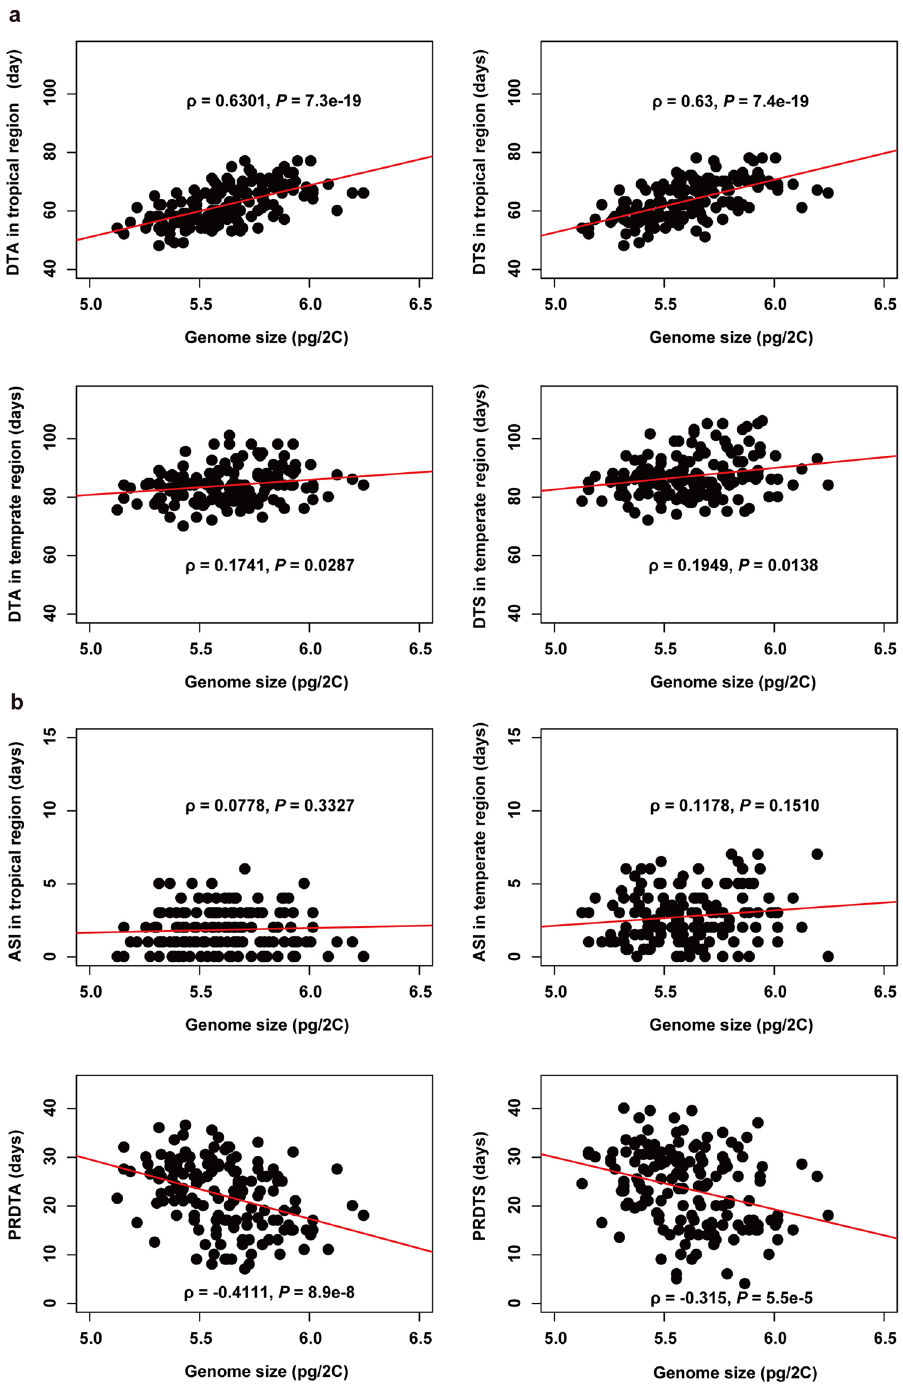
Figure 3. Moderate correlation between flowering time and genome size. ( a ) Plot of genome size and flowering time (DTA and DTS) for maize inbred lines grown in tropical and temperate regions. The x-axis is absolute nuclear content and the y-axis is flowering time. Spearman’s correlation coefficient ( ρ ) is shown for each plot. ( b ) Relationship between ASI, PRDTA and PRDTS (x-axis) and genome size (y-axis) in tropical and temperate regions. Spearman’s correlation coefficient ( ρ ) is shown for each plot. ASI in the tropical and temperate regions did not correlate with genome size. Both PRDTA and PRDTS showed a moderate negative correlation with genome size. PR: photoperiod